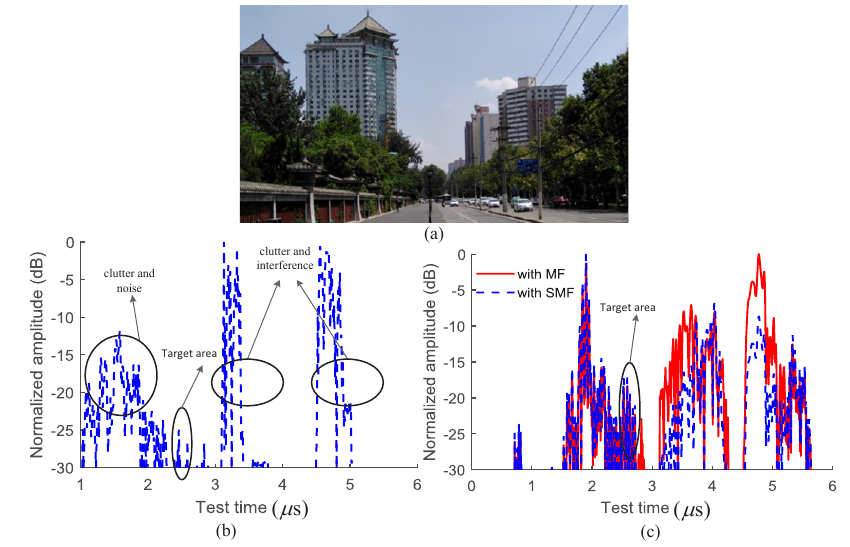
Figure 1. The test echo signal in the typical urban environment. ( a ) A picture of the typical urban environment; ( b ) the raw echo signal; and ( c ) The echo signal with the matched filter MF and the self-adaption matched filter